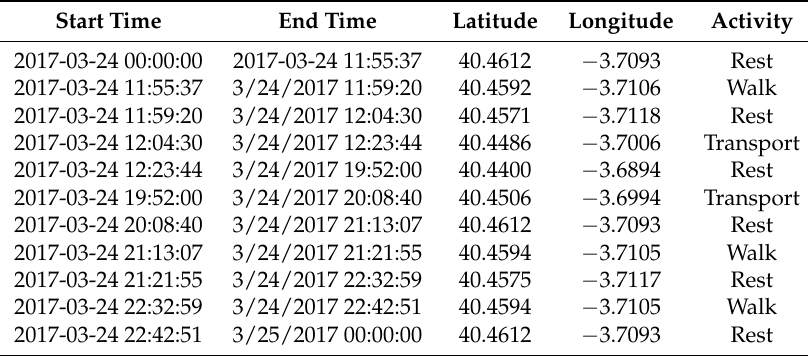
Table 4. Data from Tracking App.